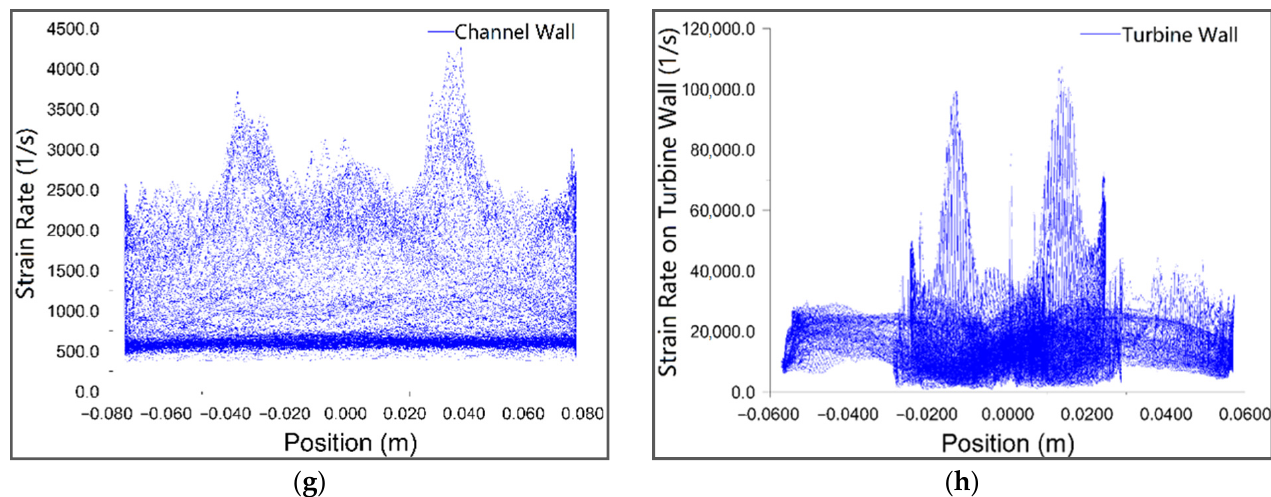
Figure 21. ( a ) The total turbulent kinetic energy of the fluid; ( b ) turbulent kinetic energy at turbine wall; ( c ) turbulent kinetic energy at channel wall; ( d ) turbulent viscosity ratio; ( e ) the skin friction coefficient of turbine wall and channel wall; ( f ) shear stress on the turbine wall; ( g ) strain rate at channel wall; ( h ) strain rate of the turbine.